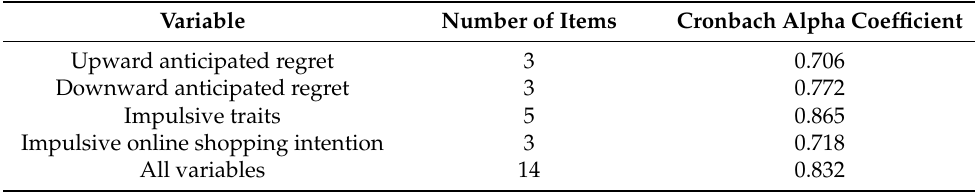
Table 2. Reliability analysis results.